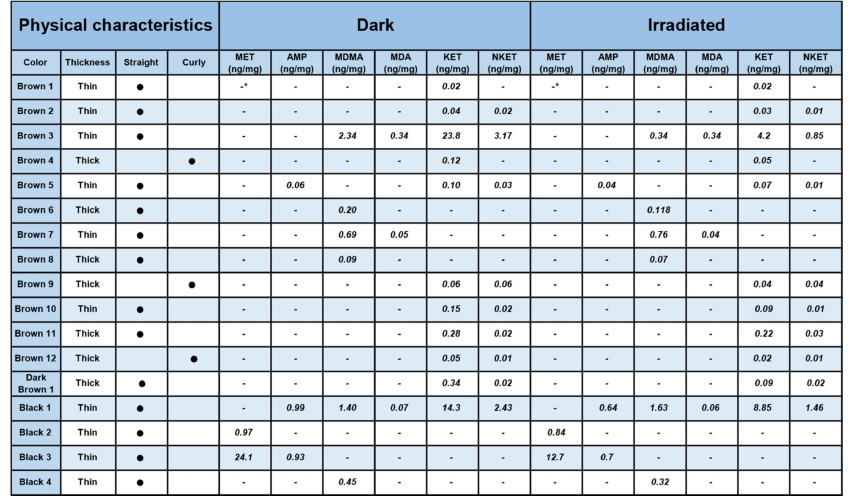
Figure 5. Drug concentrations in hair samples with their physical characteristics calculated by high-performance liquid chromatography high-resolution mass spectrometry (HPLC-HRMS) in both aliquots kept in the dark or irradiated in the solar simulator. -: absent at limit of detection (LOD, 0.005 ng/mg); ( − ) observed % increase.